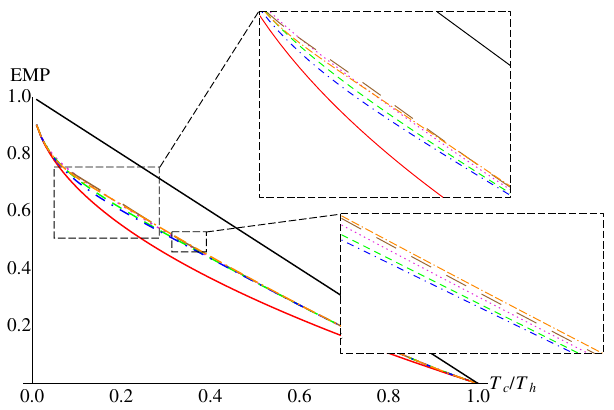
FIG. 11. EMP as a function of the ratio of bath temperatures for two topological anyons with ν = 0 (long dashed, brown), ν = 1 / 2 (short dashed, green), ν = 0.25 (dot dash dashed, orange), ν = 1 (dotted, dark pink), and two distinguishable quantum particles (dot dashed, blue) in two dimensions. The Curzon- Ahlborn efficiency (bottom solid, red) and Carnot efficiency (top solid, black) are given in comparison. The bottom inset high- lights a parameter region where an intermediate anyonic phase ( ν = 0.25) displays the greatest EMP and the top inset high- lights a region of low-temperature ratios that exhibits multiple crossings. Operation is in the quantum regime corresponding to (cid:2) ω 2 / k B T c = 10. Parameters are α c = α h = γ = 1, and τ c = τ = 0.5. h